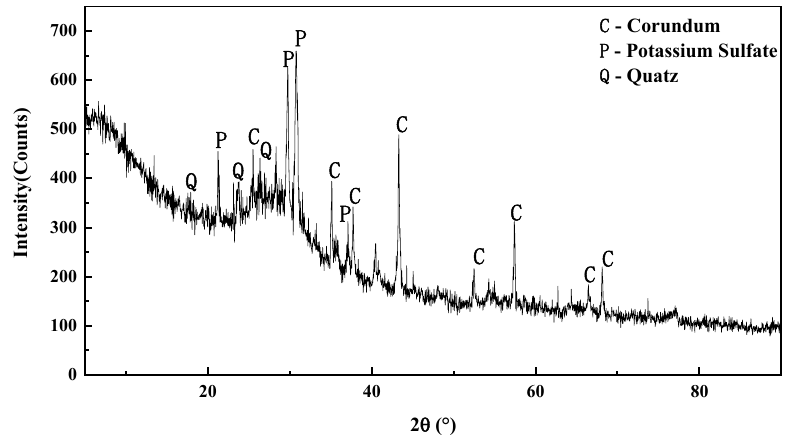
Figure 1. XRD pattern of BCFA.